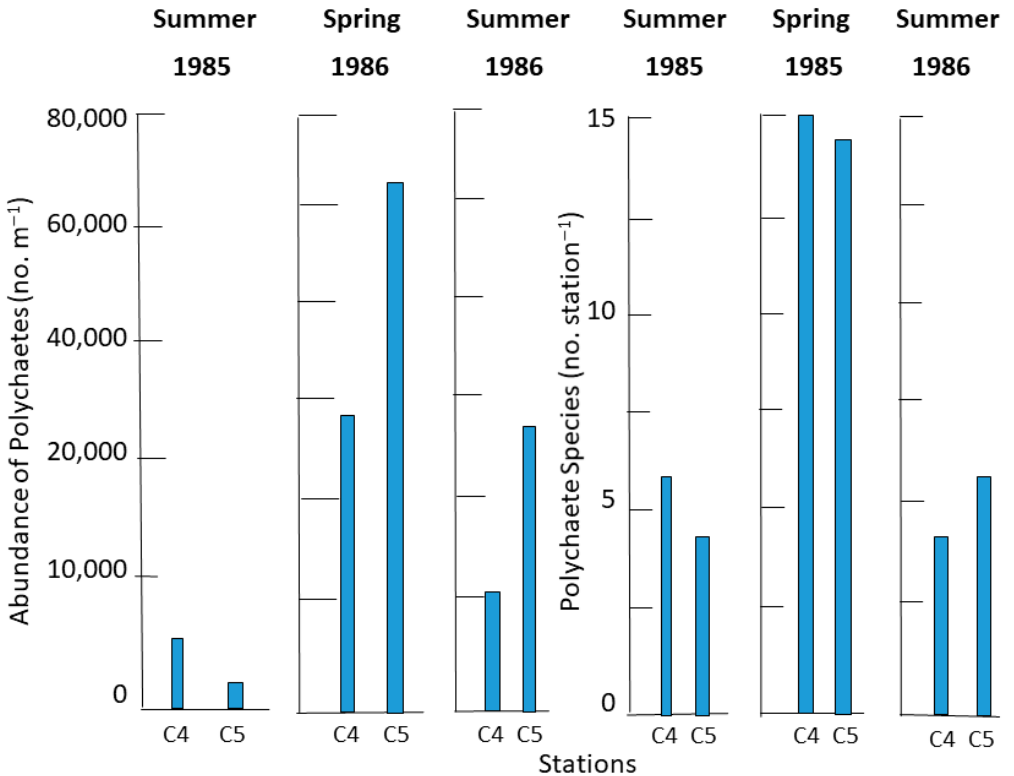
Figure 5. Data from macroinfauna studies in 1985 and 1986 on the Louisiana continental shelf from stations C4 and C5 [14] (Appendix B) for comparison to the 1978 data [17]. Data in this figure were restricted to polychaete abundance and species. The blue color identifies hypoxic conditions.